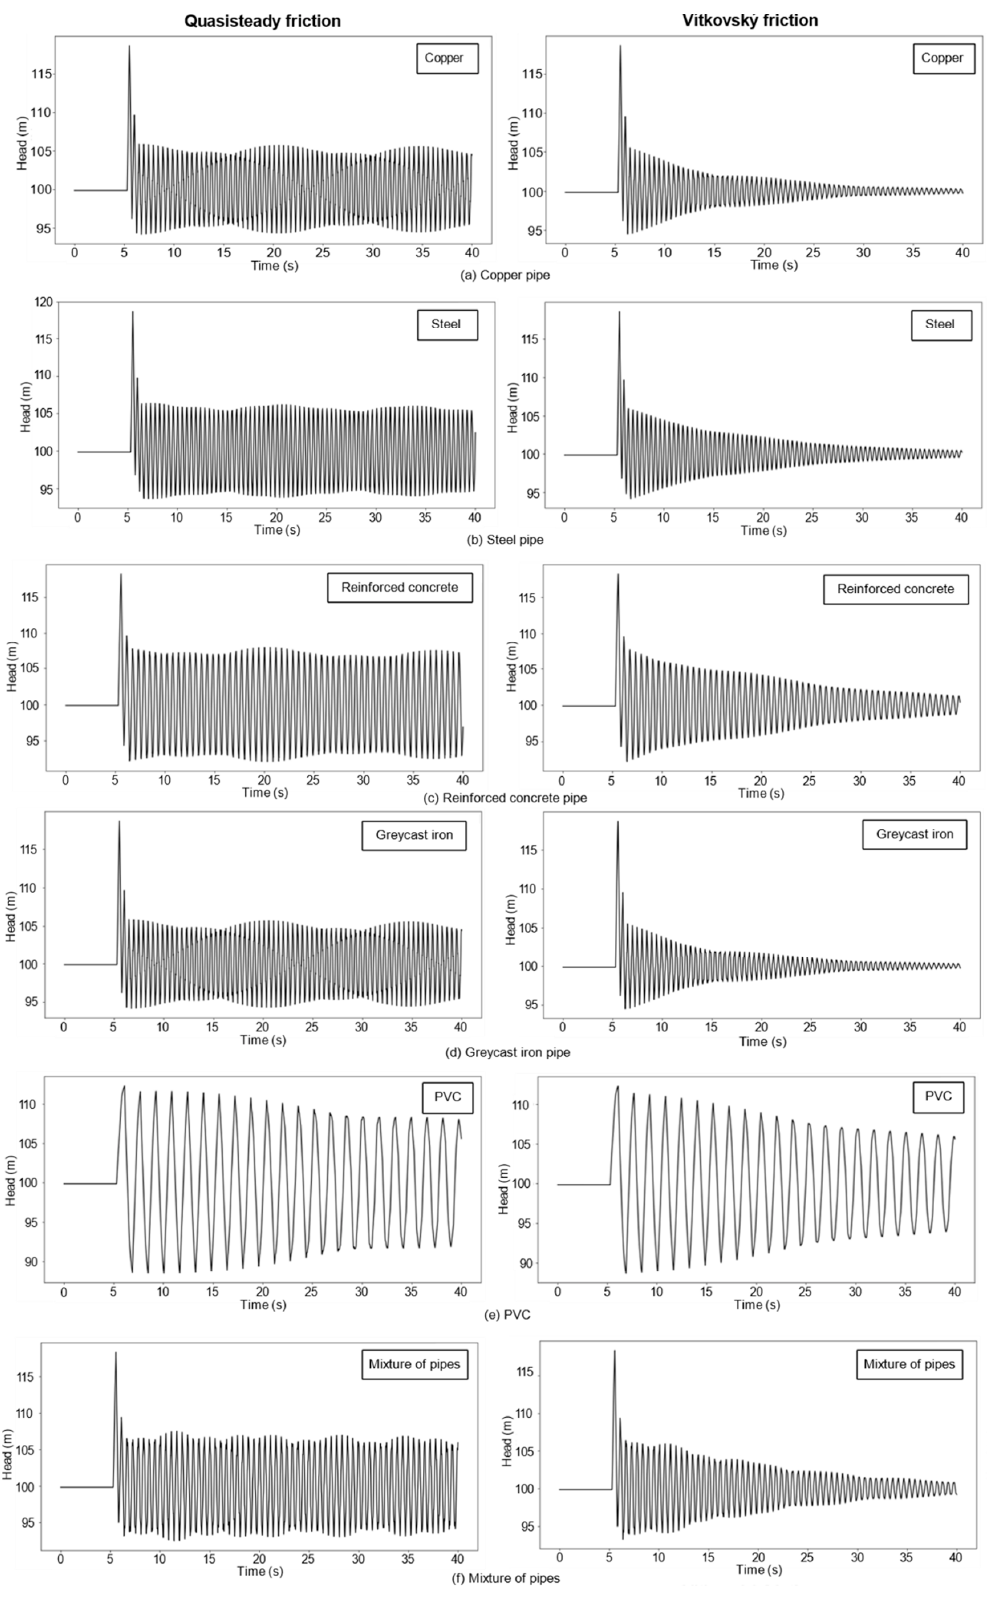
Figure 5. Effect of pipe materials at simple networks. ( a ): Copper; ( b ): Steel; ( c ): Reinforced concrete; ( d ): Greycast iron; ( e ): PVC; ( f ): Mixture of pipes.